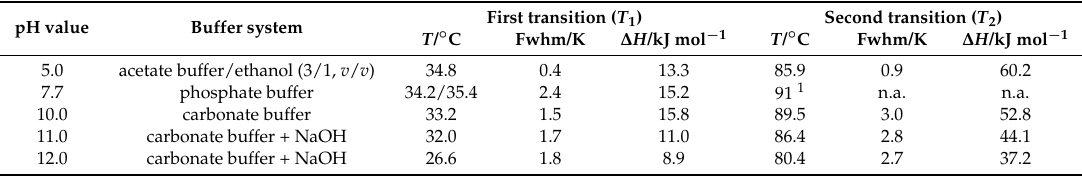
Table 1. DSC data of Me 2 PE-Gly(2C16)C32-OH suspensions ( c = 1 mg mL − 1 ) at various pH values using different buffer systems ( c = 10 mM) as indicated; data are taken from the second heating scan (heating rate 60 K h − 1